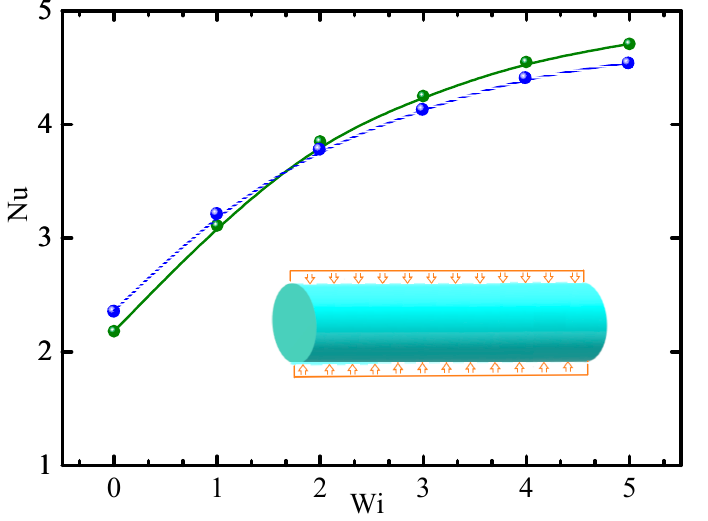
Figure 3. Variation in Nu with Wi ( Br = 0.1). ⸺ ● ⸺ : present numerical result; ⸺ ● ⸺ : theoretical solution [26].